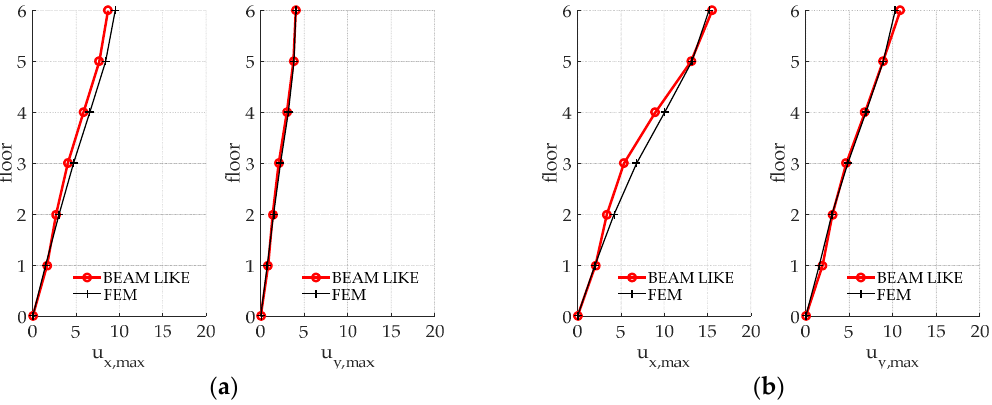
Figure 20. Six-storey benchmark. Maxima floor displacements in ( a ) Santa Venerina and ( b ) L’Aquila earthquakes.